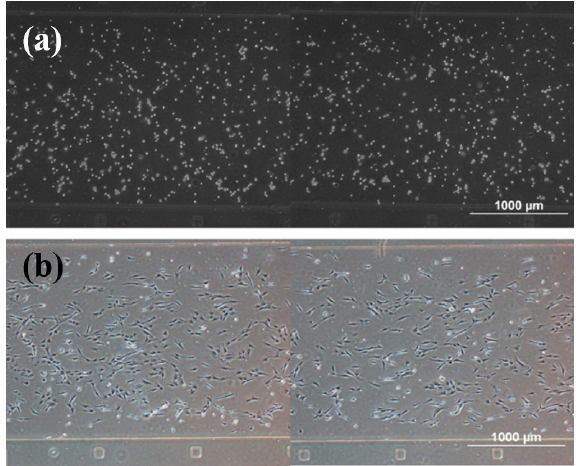
Figure 3. Microscopy images of rBMSCs seeding after ( a ) cell suspension injection and ( b ) 24 h static seeding.